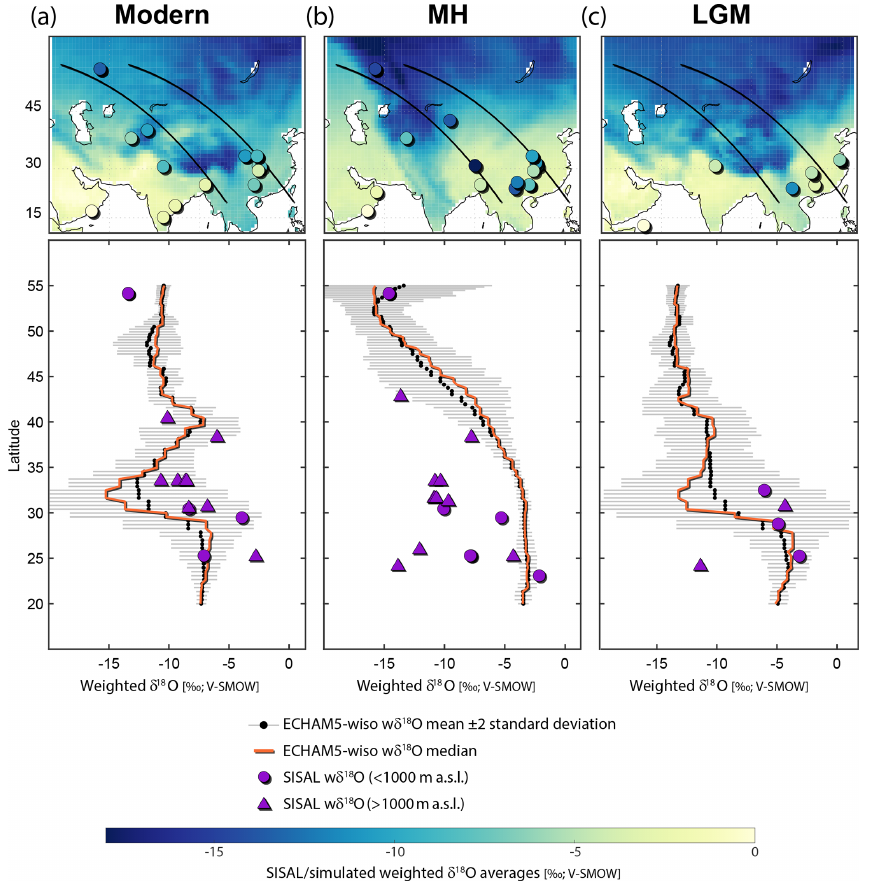
Figure 7. Latitudinal isotopic transect for Asia during the (a) modern (1958–2013CE), (b) Mid-Holocene (MH; 6 ± 0 . 5kyrBP) and (c) Last Glacial Maximum (LGM; 20 ± 1kyrBP) periods. Background maps at the top of each panel show the simulated wδ 18 O p from ECHAM5- wiso. Bottom plots in each panel show the simulated wδ 18 O p data extracted for each transect: black circles and grey whiskers are mean ± 2 standard deviation of the data extracted along longitudinal sections in between the two great circle lines shown in solid black lines in the top maps. The red line is the median of the extracted data. All data were extracted at steps of 1.12 ◦ to coincide with the average model grid size. These bottom panels also show SISAL δ 18 O: circles for low-elevation sites, <1000ma.s.l.; triangles for high-elevation sites,